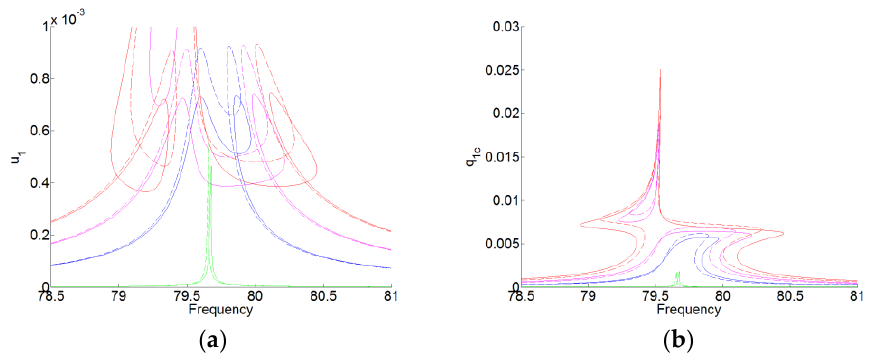
Figure 3. The periodic forced responses of the system for F 1 = [ 0.01 : 0.6 : 2 ] . ( a ) u ( t ) and ( b ) q ( t ) . The dashed lines represent the responses without the pre-stress of the membrane. The solid lines represent the responses with the pre-stress of the membrane ( f 1 = 30 Hz ).